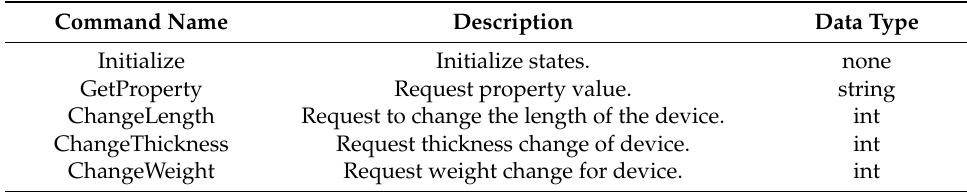
Table 2. Daemon-side command list of contents.